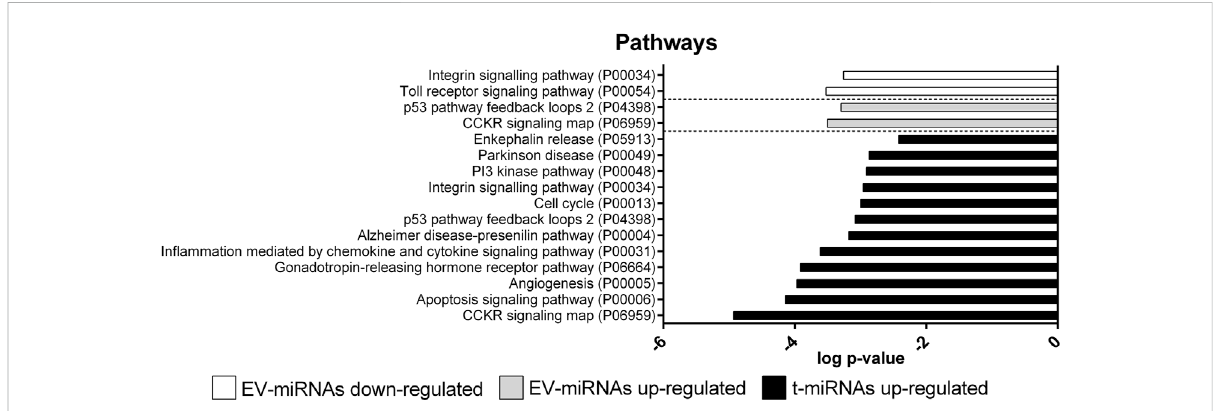
FIGURE 7 Pathway enrichment analysis of target genes predicted for up- and down-regulated t- and EV-miRNAs. Pathway enrichment analysis for the target genespredicted for up-regulated t-miRNAs ( n =161),up-regulated EV-miRNAs( n = 246),and down-regulated EV-miRNAs ( n =102). Analysis was performed using Panther ver 17.0 (http://www.pantherdb.org/) and all the pathways were shown. Statistical overrepresentation tests showing the p -value of each pathway are shown in Supplementary Tables S7 – S9